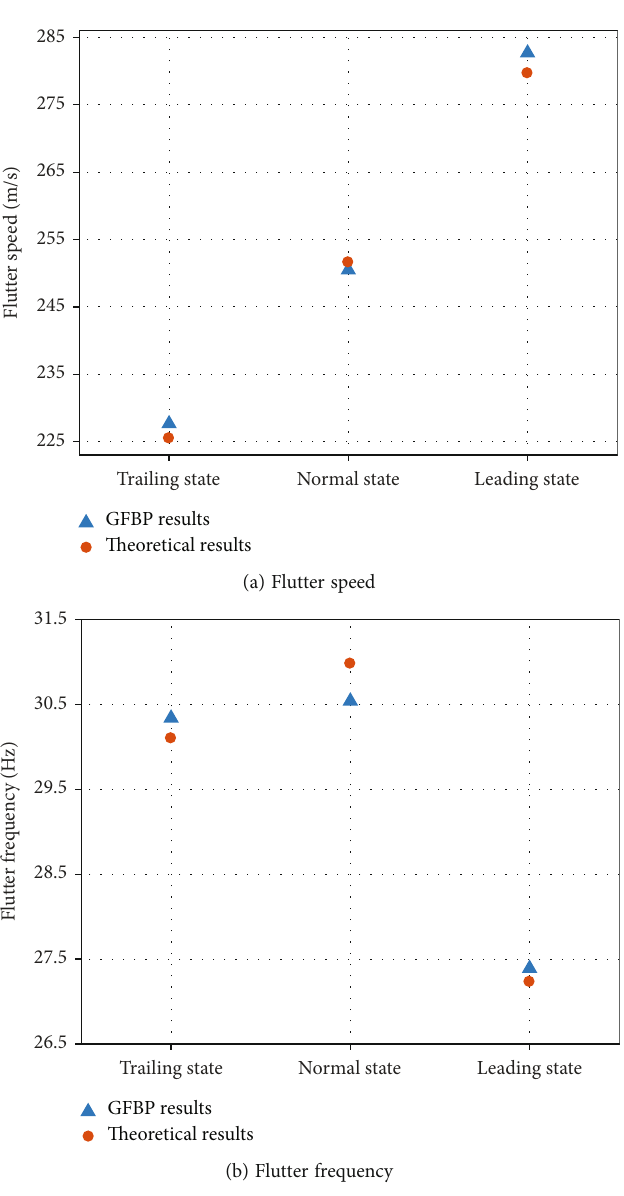
Figure 14: Comparison of fl utter results for the three states at Ma = 0 : 2